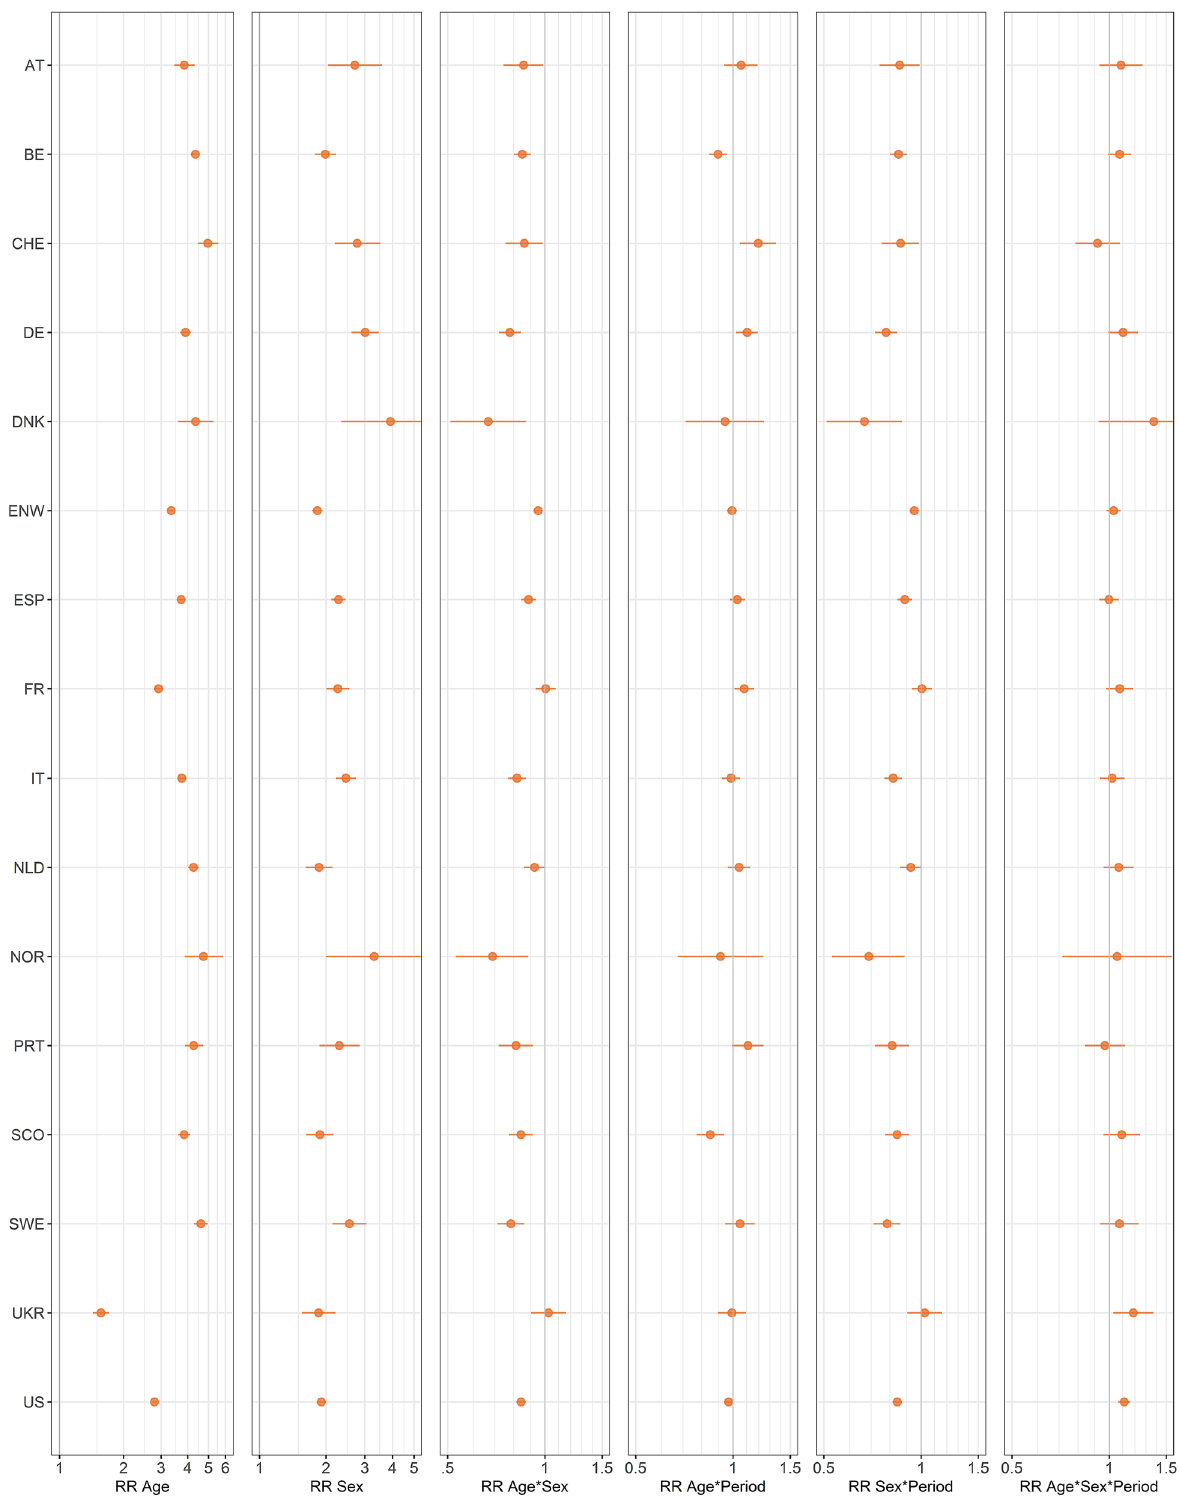
Figure 4. Analysis of COVID-19 mortality in dependency of age, sex, and period in the 16 countries. Estimates and 95% confidence intervals for the risk ratios of age (per 10 years), sex, period, twofold interactions (age × sex, age × period, sex × period), and the threefold interaction (age × sex × period) for COVID-19 mortality from Model 2 COVID. Country codes are defined in Table